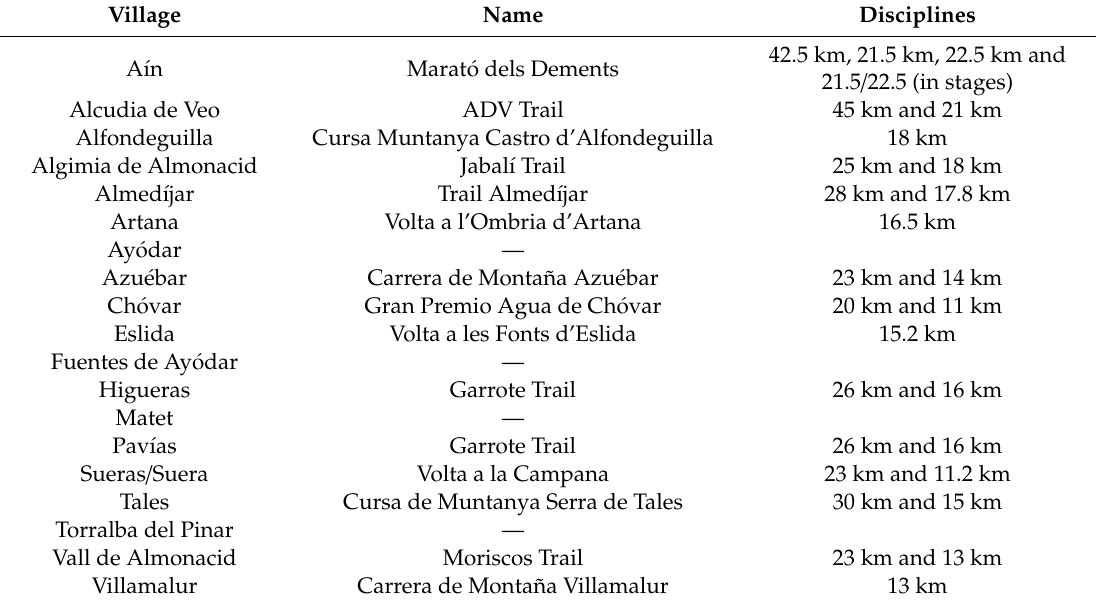
Table 3. Mountain trail running races organised in the Sierra de Espad á n Natural Park. Village